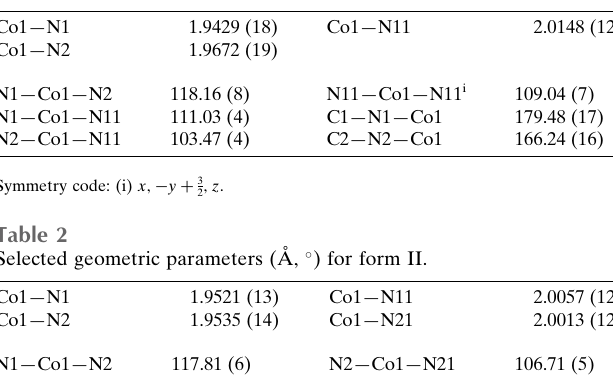
Table 3 Hydrogen-bond geometry (A˚ , (cid:4) ) for form I.